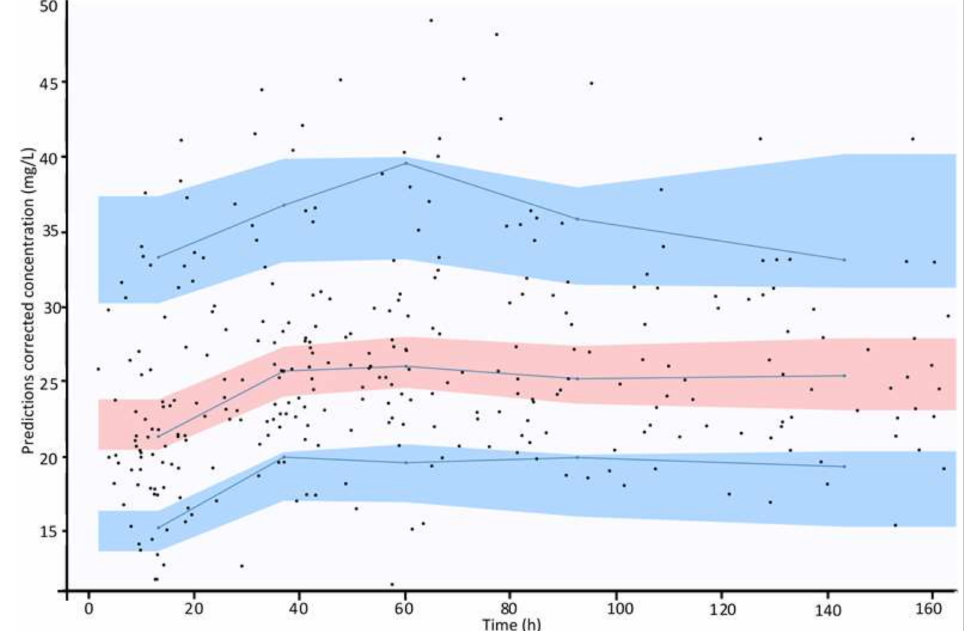
Figure 2. Internal validation of the model: prediction-corrected visual predictive checks.